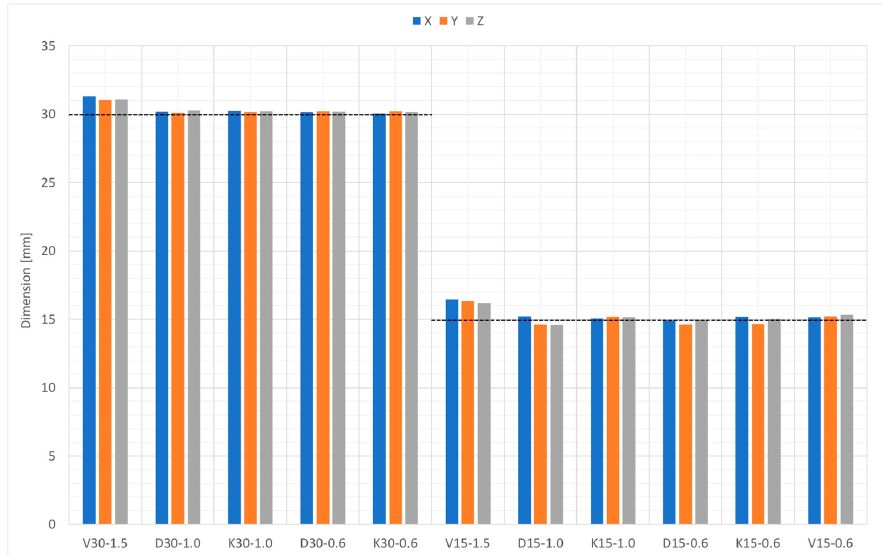
Figure 10. Bead dimensions in the X-, Y-, and Z-direction. Table 6. The beads’ morphometric parameters determined by XµCT analysis. The nominal values for strut thickness, volume, and open porosity are reported for reference. Morphometric Parameters